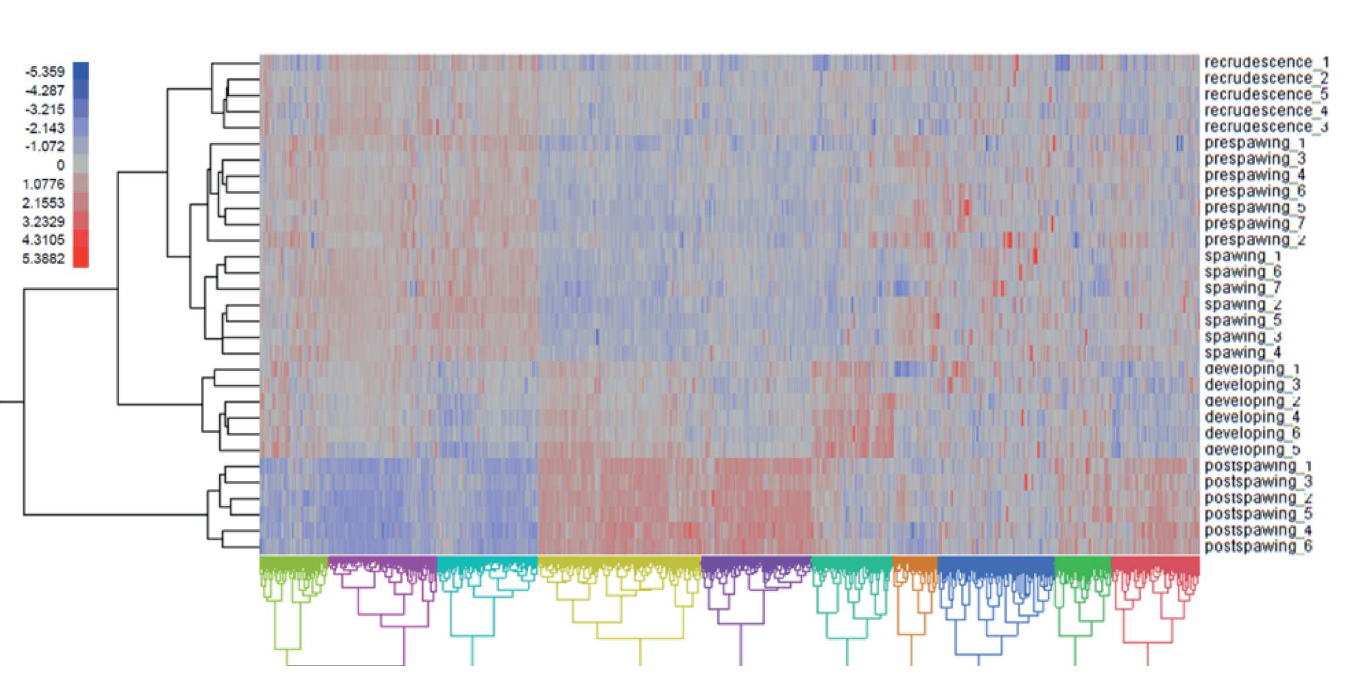
Fig 5. Hierarchical clustering of differentially expressedgenes (p < 0.05) in the male gonad of rainbow darter over the different stages of development (i.e. recrudescence, developing, pre-spawning, spawning and post-spawning). Each row numbered represents different individualfish within a treatment; each column represents a specific gene. Co-expressedgeneswere classifiedin 10 major clusters (from A to J). Blue indicateslow mRNA levels (relative) and red indicateshigh mRNA levels